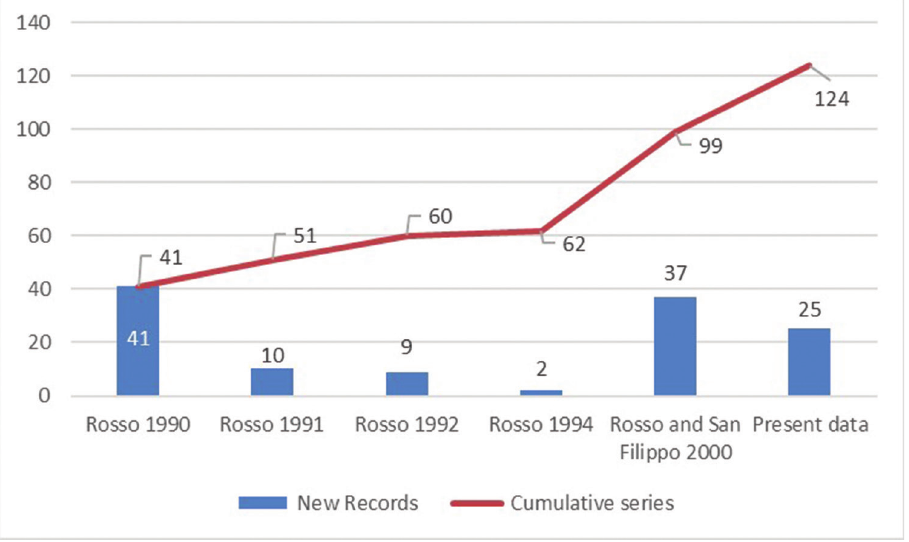
Figure 10. Histogram depicting the number of new records (blue bars) and their cumulative series (red line) reported by literature and this publication for the Terra Nova Bay